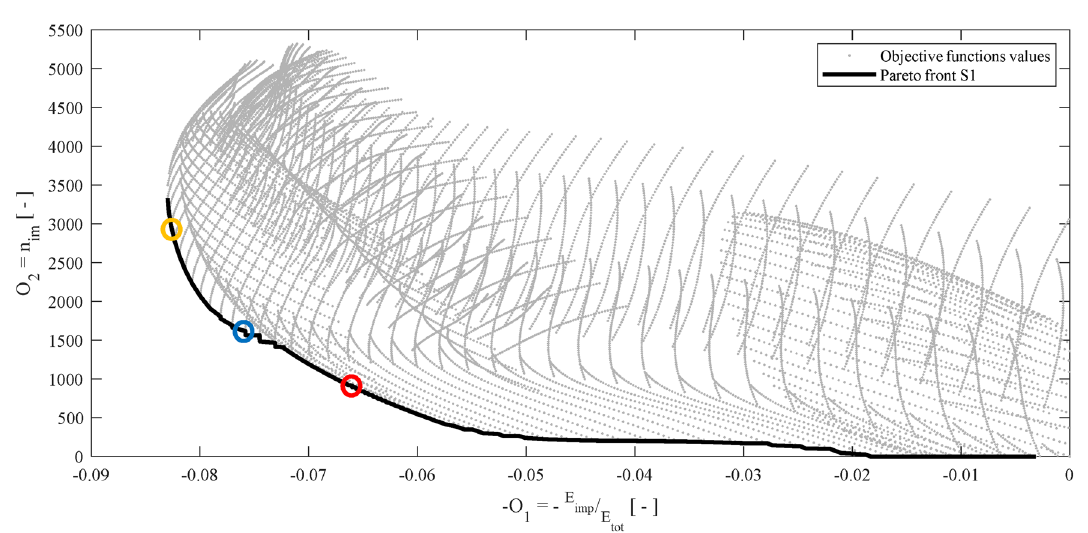
Figure 9. Plot of all the realizations of the Kriging metamodel and the Pareto front S1 ; the circles indicate the three optimal solutions investigated in the Subsection “Fragility assessment and selection of the optimal